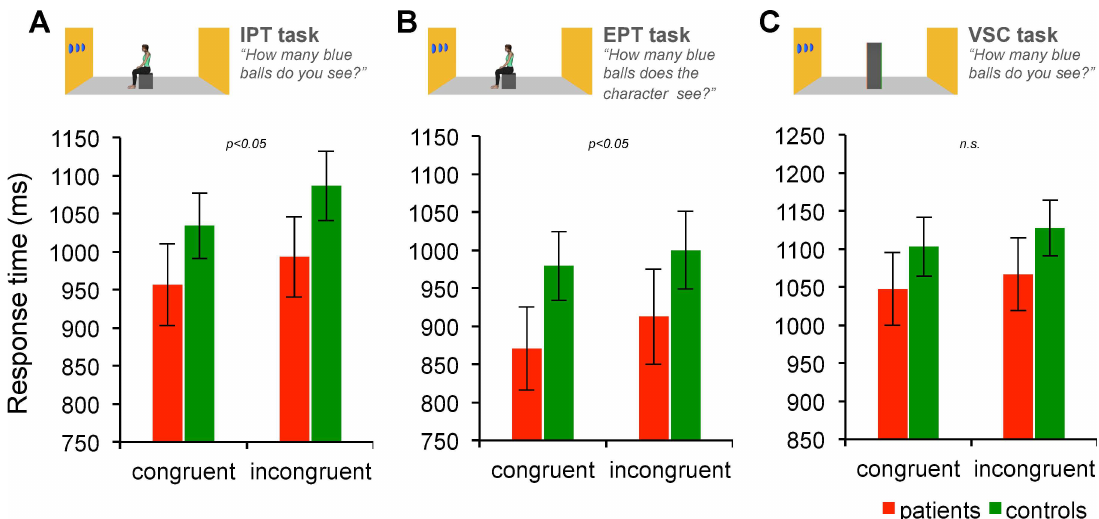
Fig 2. Results for the visuo-spatial perspective-taking tasks (Experiment 1; Response times). Histogramsrepresent the effect of the within-subject factor Viewpoint,which was significantfor the implicit perspective-taking (IPT) task (p < 0.05)and the explicit perspective-taking (EPT) task (p < 0.05), but not for the visuo-spatial control (VSC) task (n.s.: not significant). Data for patients and controls are shown separately for illustrationpurposes only. Vertical bars represent the standarderror of the